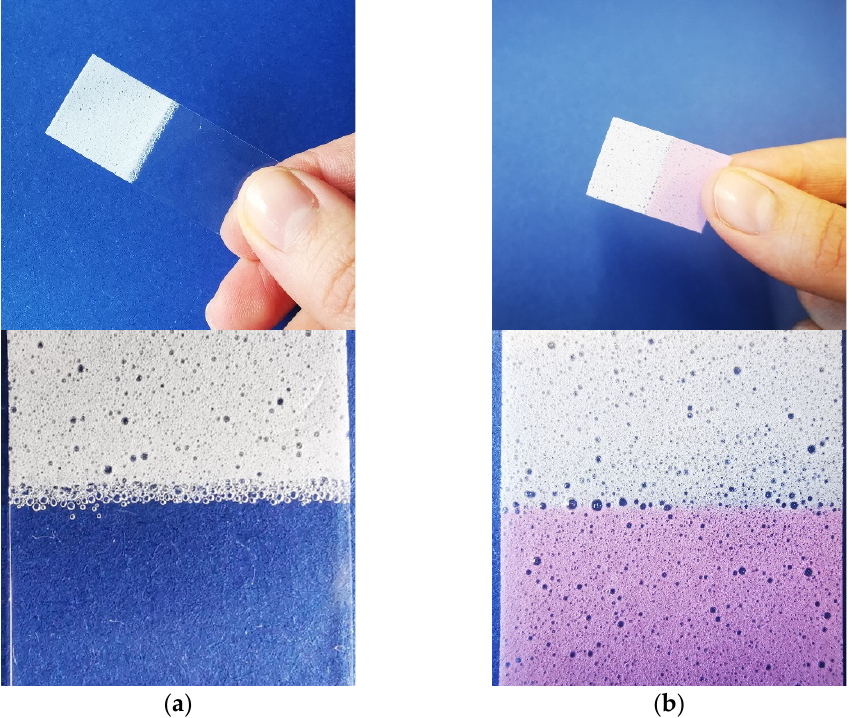
Figure 9. Applicator films with a ( a ) water-insoluble EC applicator and ( b ) water-soluble PVA applicator. The pictures were taken in front of a blue background.